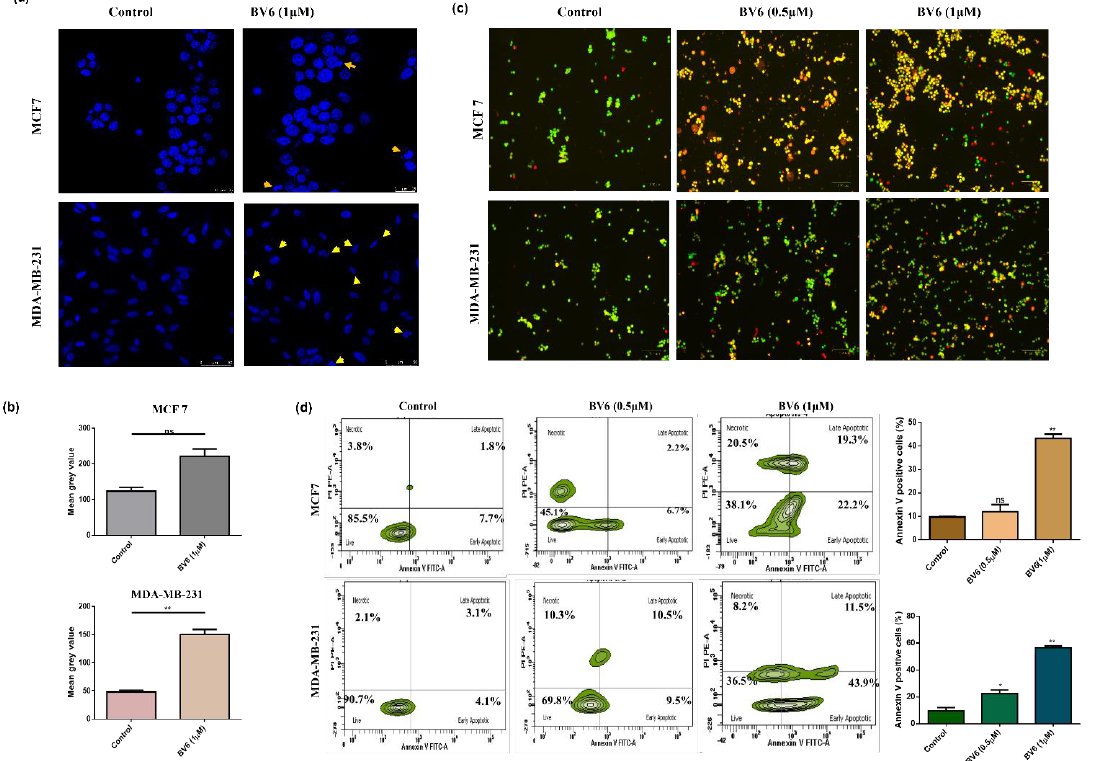
Figure 2. ( a ) DAPI staining of MCF7 and MDA-MB-231 breast cancer cells: Treatment of BV6 for 24 h shows apoptosis induction. DAPI staining images demonstrating changes in the nuclear